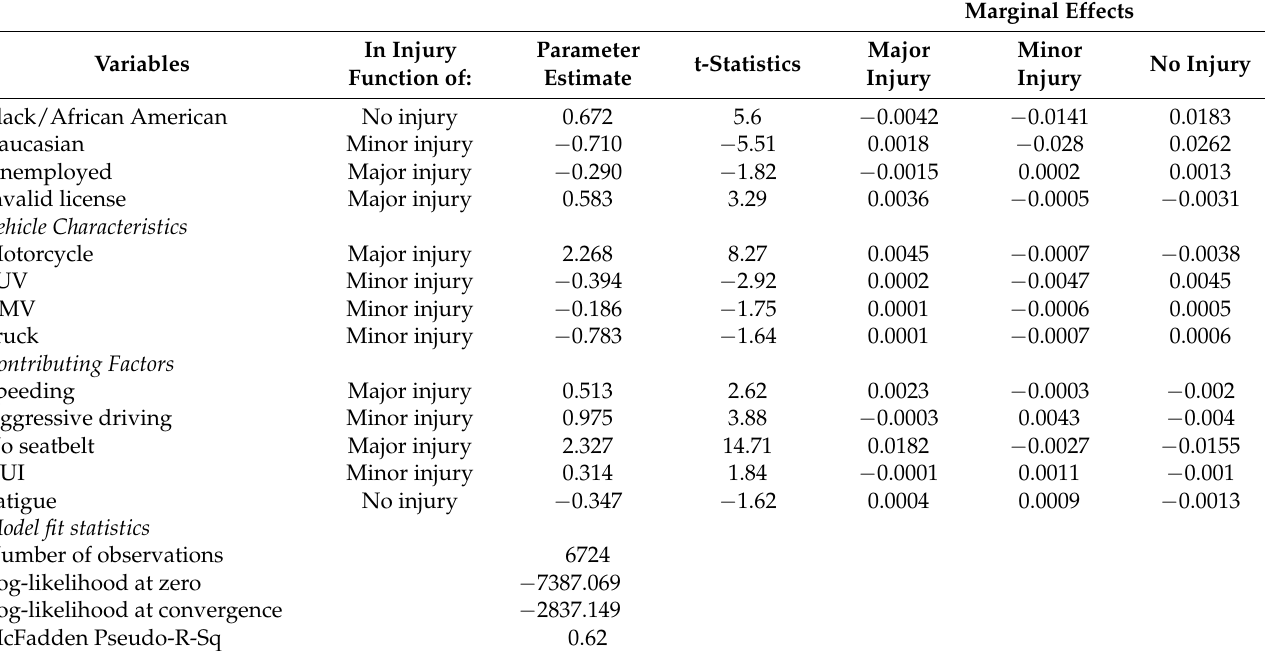
Marginal Effects